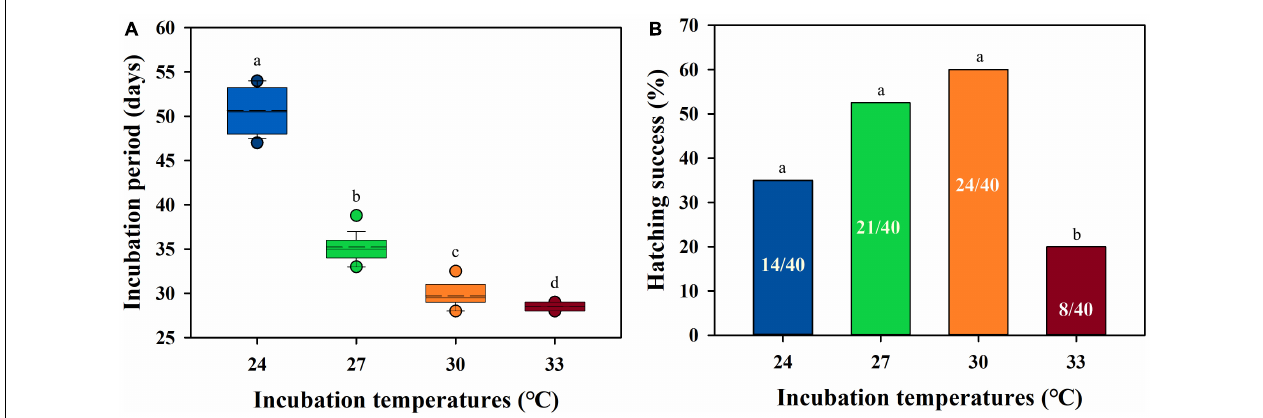
FIGURE 3 | Incubation period (A) and hatching success (B) of embryos under 24, 27, 30, and 33 ◦ C. (A) The dash lines indicate the mean value of incubation period; the data are shown as mean ± SE . (B) The number in the columns indicate the sample size for each temperature. The different letters above the error bars indicate the significant difference between incubation temperatures.